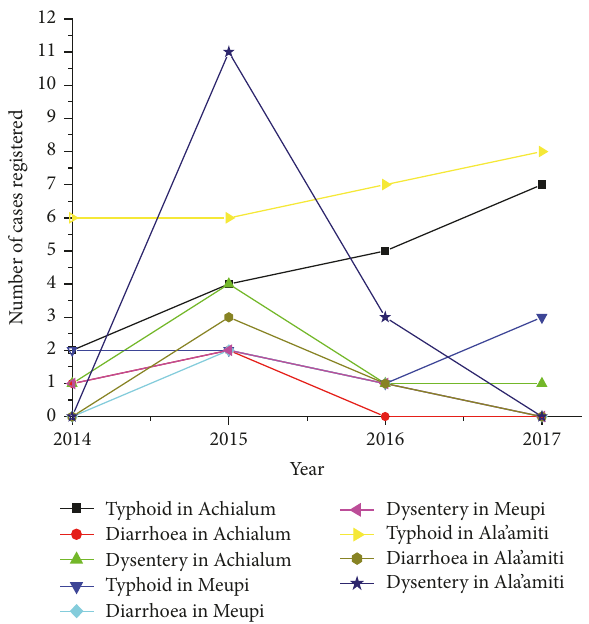
Figure 3: Water borne diseases registered in the sampled areas for the past four years (source: Awing Health